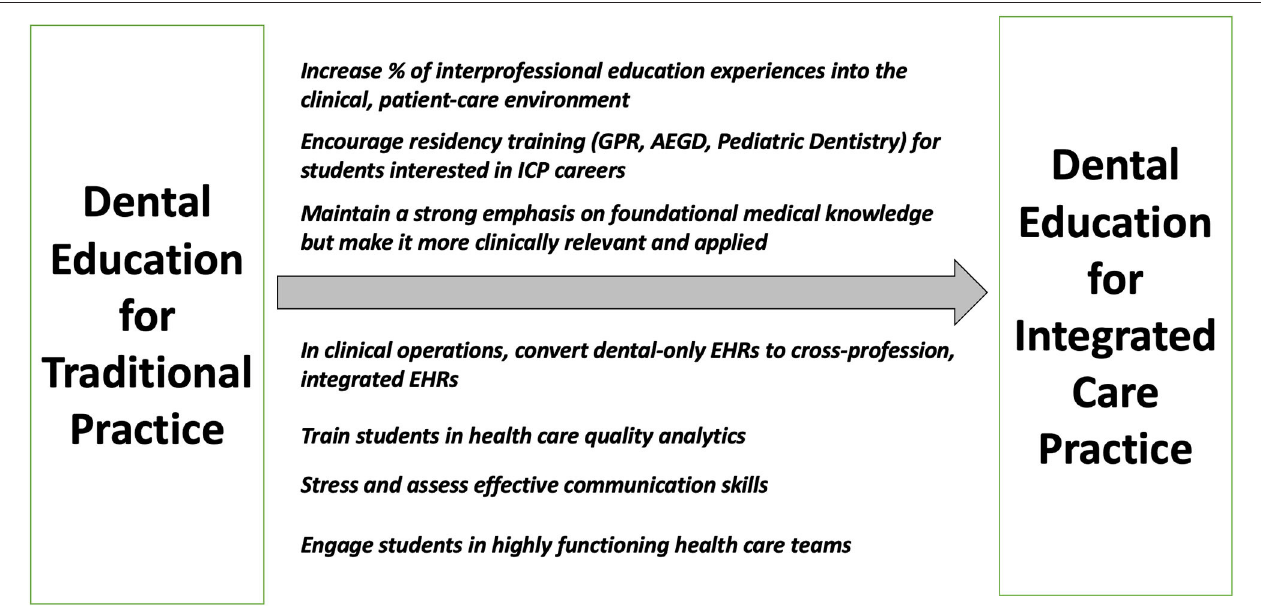
FIGURE 1 | Integrated care practice leader recommendations for improvement in the education and preparedness of dentists for future practice.